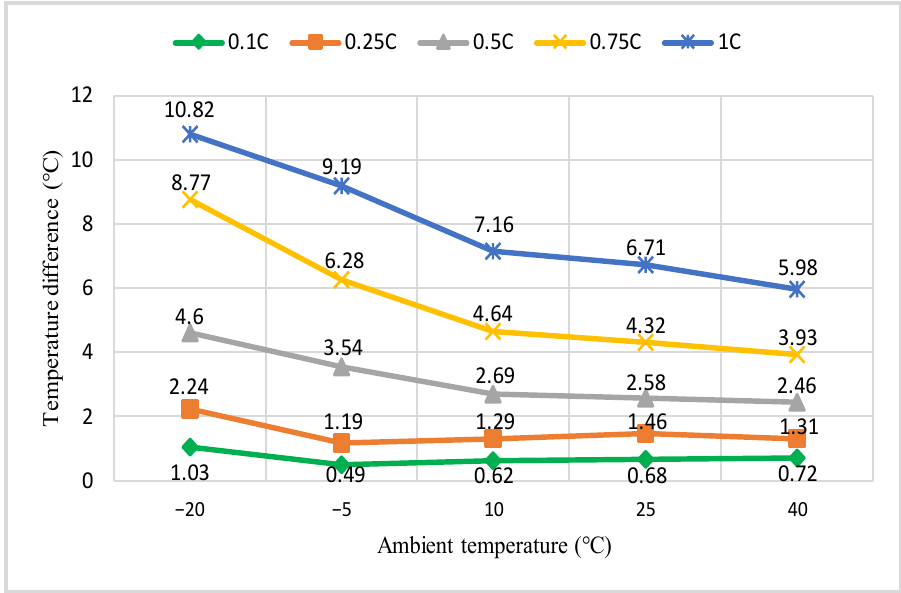
Figure 17. Analysis of the highest temperature variation of the battery ’ s surface.